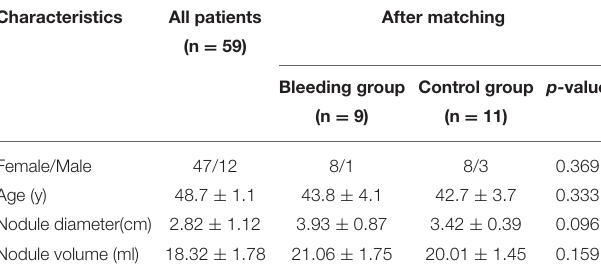
TABLE 1 | Characteristics of patients with cystic thyroid nodules.